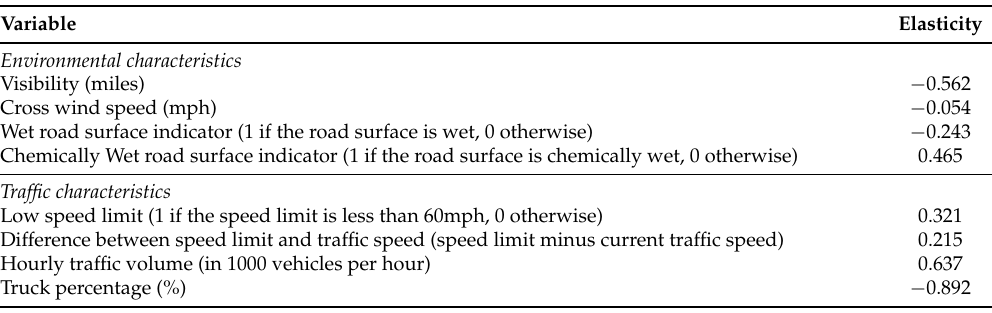
Table 3. Elasticity estimates for crash frequency